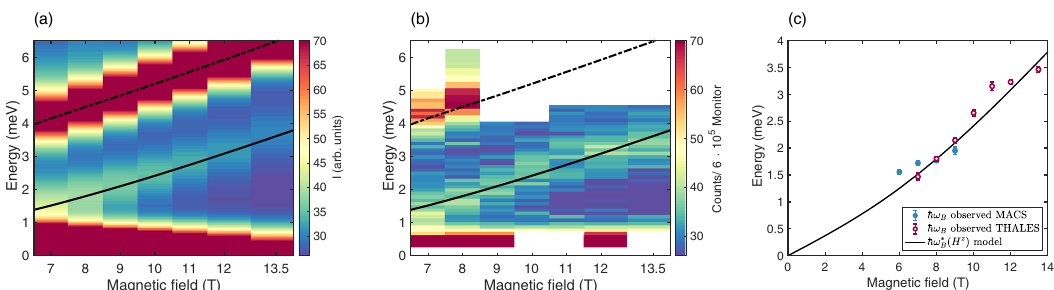
Fig. 6 Field dependence of the Bloch energy. The fi eld dependence of the RPA calculations at Q L = 1.0 r.l.u are shown in panel a convoluted with a Gaussian function as described in the main text. The corresponding data measured at ThALES are shown in panel b . The positions of the MBO peak for the energy scans shown in Fig. 5 and in Supplementary Figs. 8 and 9 are shown in panel c . The error bars correspond to one standard deviation on the parameter in the fi t to the experimental data. Results obtained from MACS data are shown with solid blue circles and results obtained from ThALES data are shown with open red circles. In all panels, the black lines correspond to the predicted Bloch energy _ ω (cid:5) parameters. In panels a , b , the black dashed lines correspond to the position of spin-wave excitation, between λ l ¼ 0